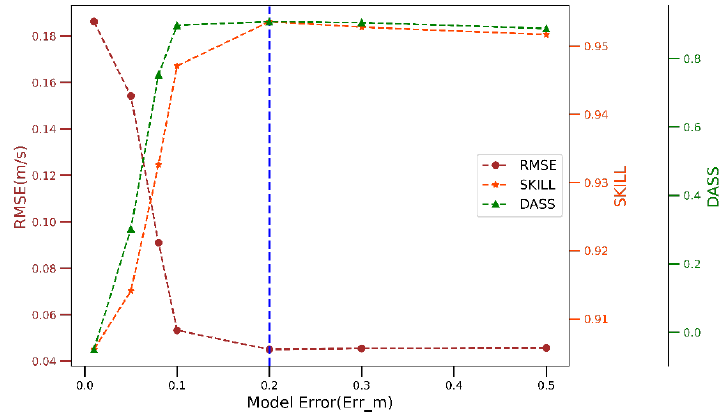
Figure 7. Model error ( Err m ) versus RMSE, SKILL, and DASS of PF.